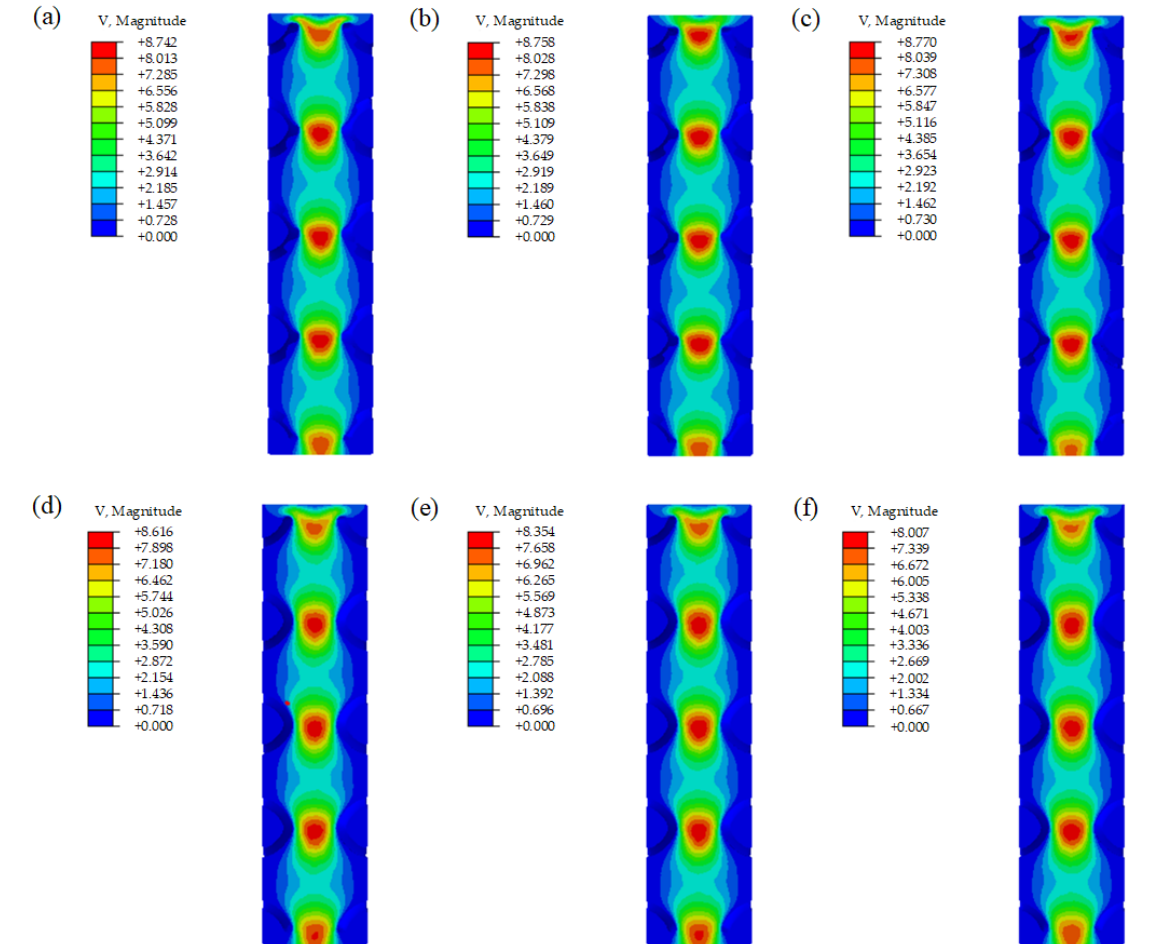
Figure 8. Velocity contours from CFD analysis of ( a ) P0.6A1, ( b ) P0.6B1, ( c ) P0.6C1, ( d ) P0.6A2, ( e ) P0.6B2, and ( f ) P0.6C2.